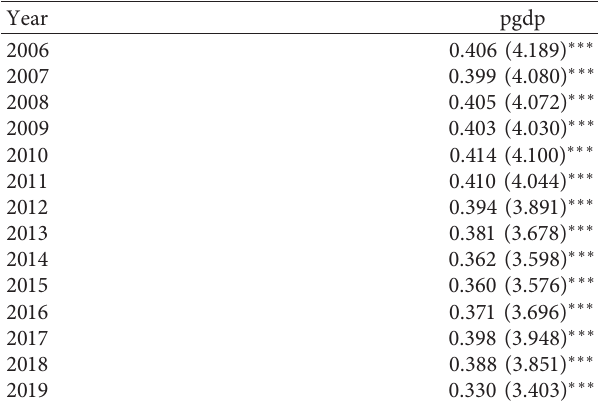
Table 3: Global Moran’s I results for